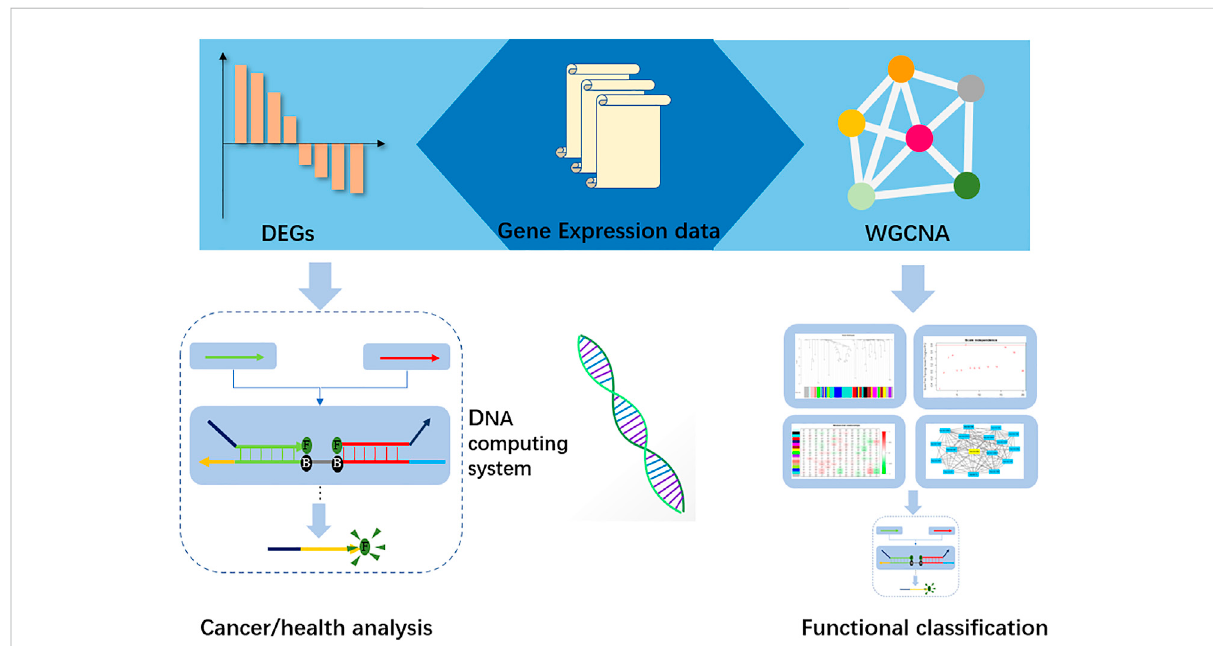
FIGURE 1 Work fl owoftheDNAcomputingsystem.GeneexpressiondatawereusedtoidentifythebiomarkersinDifferentialexpression(DEGs),andhub- geneswerefoundbyWeightgeneco-expressionnetworkanalysis.Thosebiomarkersandhub-genesweresubmittedtotheDNAcomputingsystem for cancer analysis and functional classi fi cation,